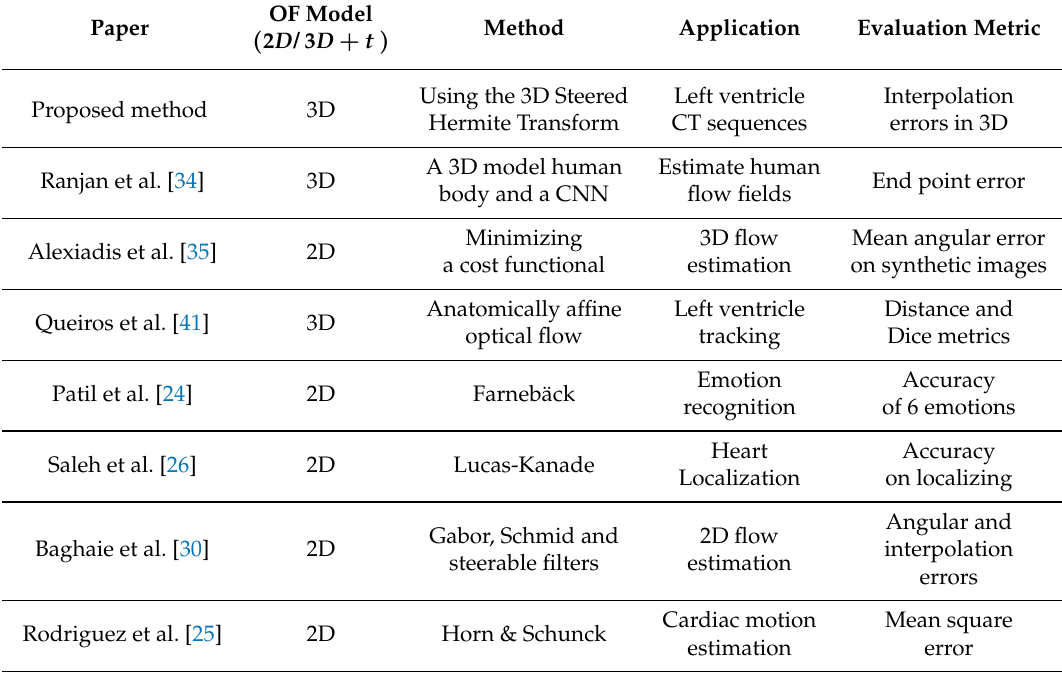
Table 1. 2 D /3 D + t optical flow estimation